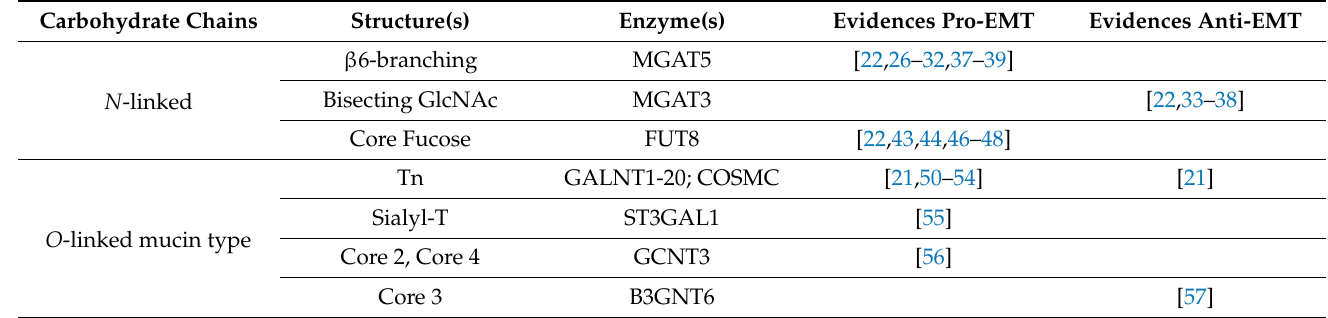
Table 1. Summary of the effects of various carbohydrate structures on EMt. Carbohydrate Chains